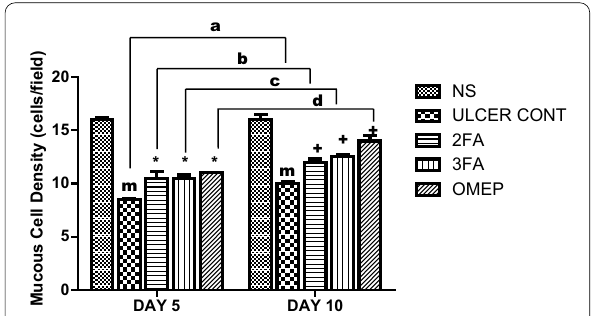
Fig. 10 Effect of folic acid and Omeprazole on mucous cell density during healing of acetic acid induced gastric ulcer. (* , + p < 0.05 cf ulcer control; a–d p < 0.05 cf. each group on day 10 m p < 0.05 cf NS). ULCER CONT Acetic acid Ulcer control, 2FA 2 mg/kg Folic acid, = = 3FA 3 mg/kg Folic acid, OMEP = =